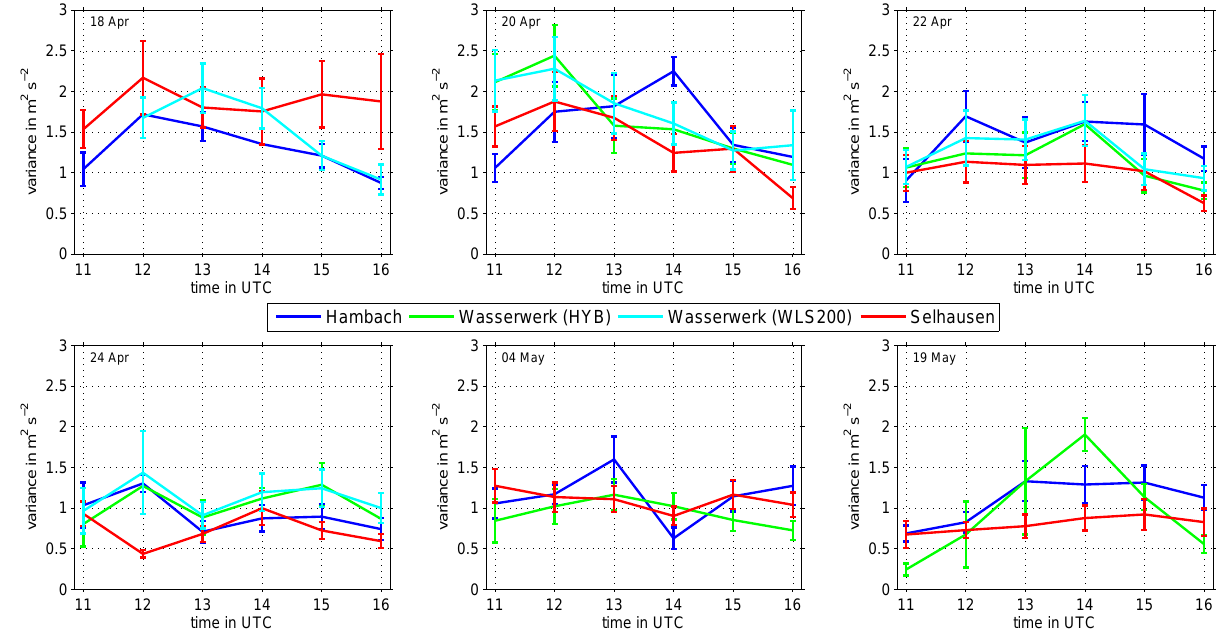
Figure 10. Vertical velocity variances (hourly profiles averaged over z max ± 250m) at the three locations with error bars displaying the statistical error according to Lenschow et al. (1994) for all 6 days (different